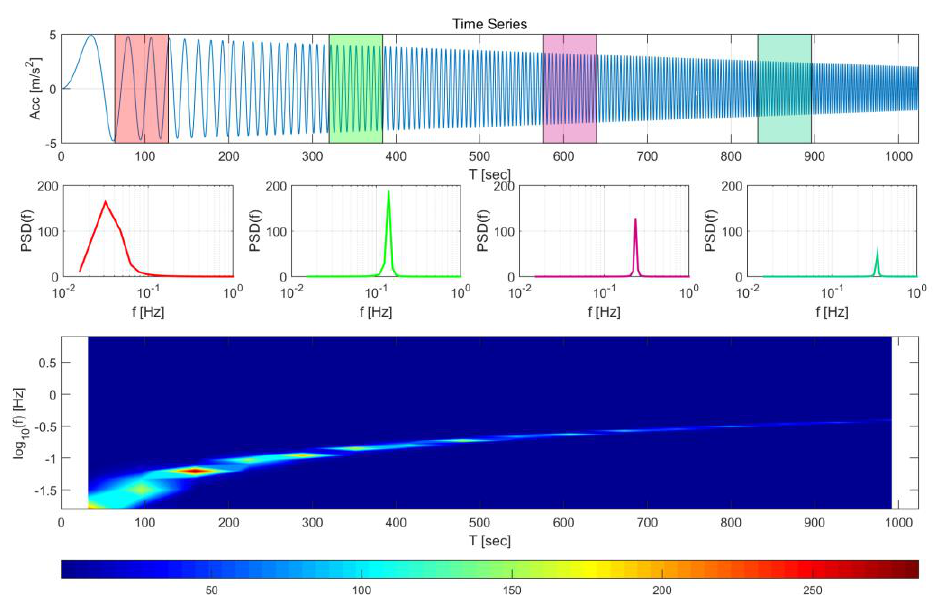
Figure 4. Example of a short-time Fourier transform (STFT) and associated spectrogram.